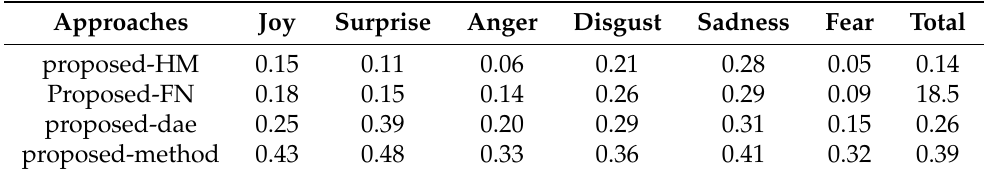
Table 7. The per-class emotional performance of elimination experiments with BAUM-1s dataset.